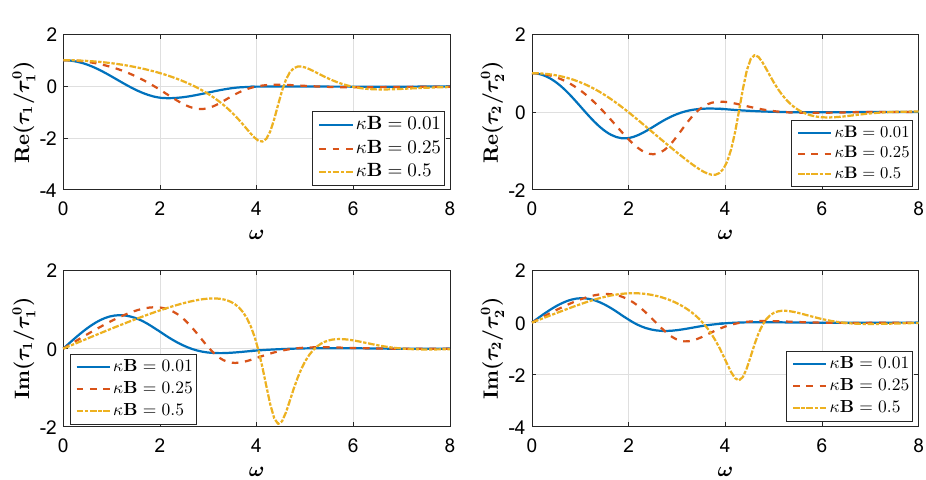
Fig. 3 Normalised AC conductivities τ 1 /τ 0